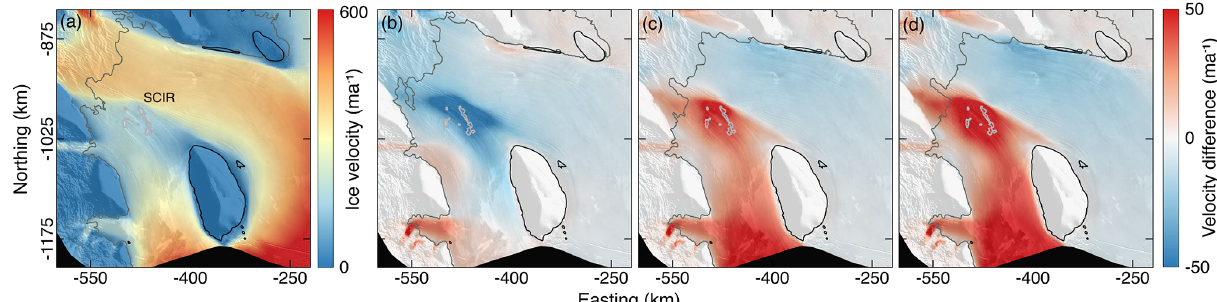
Figure 4. Ice velocity response to different friction coefficient values assigned to the SCIR model nodes. (a) Modelled ice velocity when α = 200s 1 / 2 m − 1 / 2 . (b–d) The difference in ice velocity between the reference model ( α = 200s 1 / 2 m − 1 / 2 ) and alternative relaxed models with varying α values assigned to the SCIR nodes before model relaxation. In panels (b) , (c) and (d) , α = 0, 400 and 600s 1 / 2 m − 1 / 2 , respectively. The range α = 0, 200, 400, 600s 1 / 2 m − 1 / 2 corresponds to τ b = 0, 51, 67, 86kPa (i.e. no basal traction or soft subglacial sediment, through to hard bedrock). Grounding-line positions are from the relaxed models with varying α